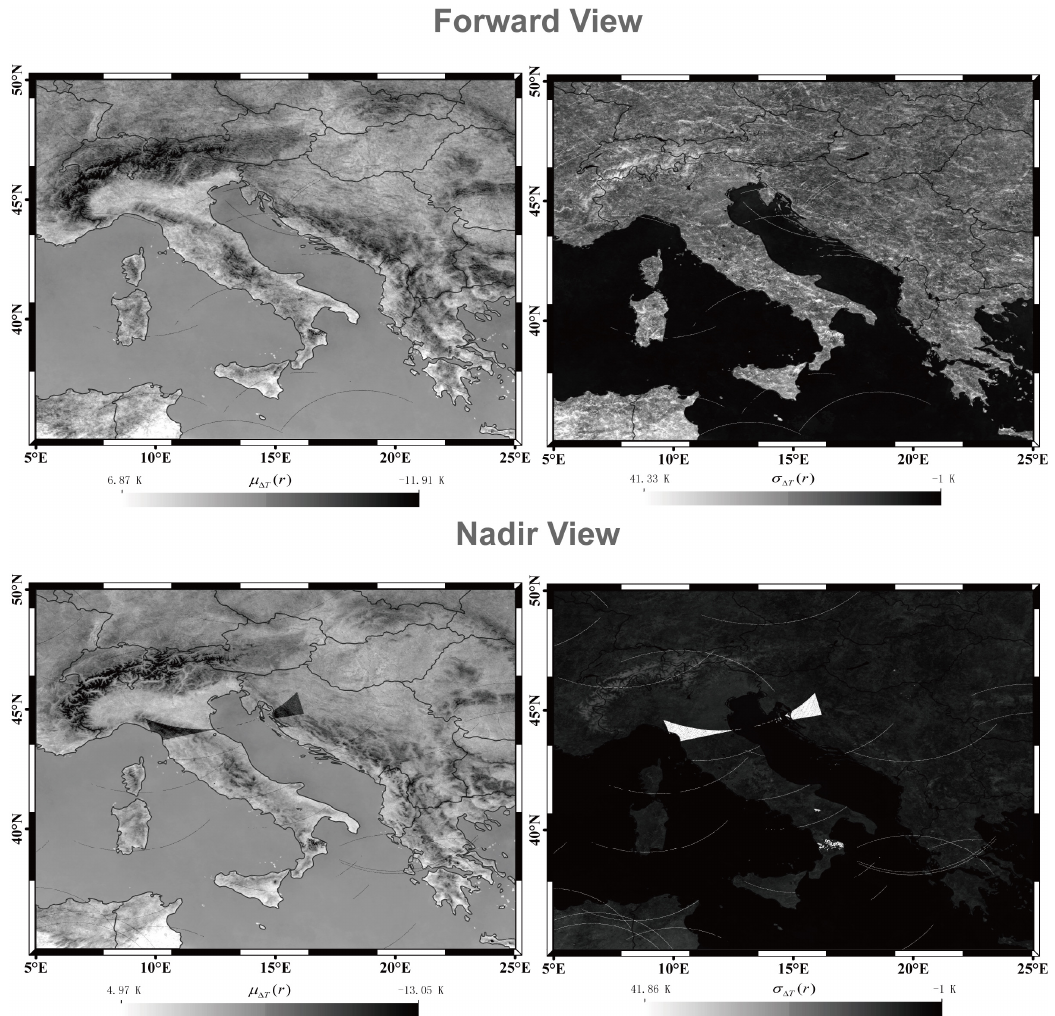
Fig. 4. Reference fields for the investigated area of forward view and nadir view computed from bi-angular AATSR data from 2003 to 2009 during the months of April.